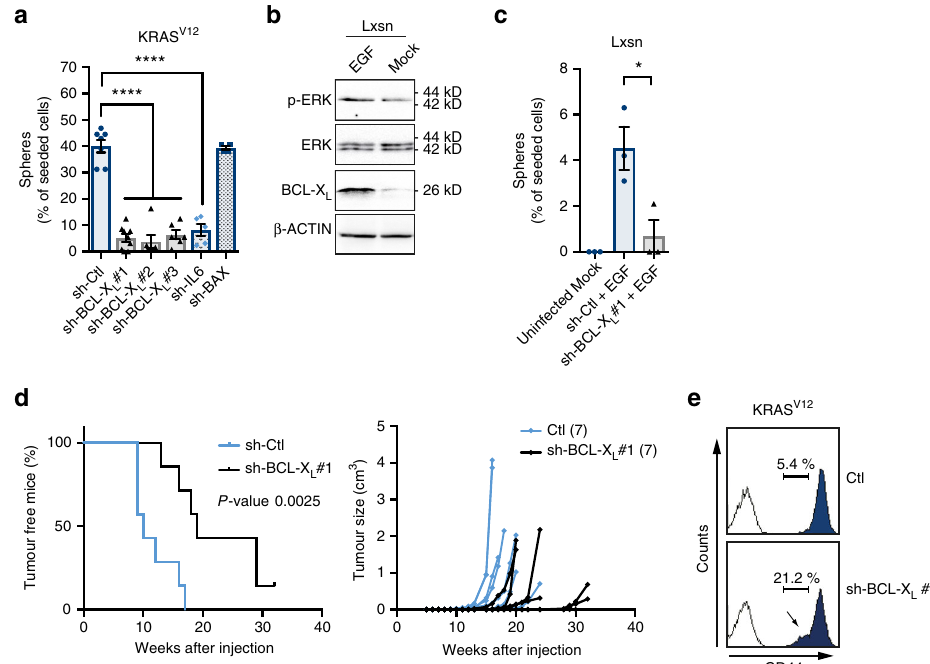
Fig. 2 BCL-X L maintains cancer initiating cell features induced by RAS activity in mammary cells. a , b Percentage of sphere forming cells in bulk population of a MCF10A KRAS V12 cells or c EGF-treated MCF10A Lxsn cells after 72 h infection with the indicated lentivector sh-RNAs. As comparison, the measured lack of sphere formation of Lxsn untreated with EGF is also illustrated. 128 cells per condition were seeded in serum-free media in ultra-low adhesion plates and the resulting spheres counted after two weeks incubation. Each dot represents the percentage of cell forming sphere for one biological replicate. Mean and SEM of at least 3 (3 to 6) independent experiments are represented (two-tailed unpaired t -test). b Western blot analysis of BCL-X L expression and ERK phosphorylation in MCF10A Lxsn cells after overnight starvation and treatment with 20 ng ml − 1 EGF for an additional 24 h d . Transplant experiment of MCF10A KRAS V12 cells infected with sh-BCL-X L or a control vector. 5 × 10 5 cells were subcutaneously injected in 7 Nu/Nu mice for each group and tumour growth was monitored (Log-rank (Mantel-Cox) test). e Flow cytometry analysis of CD44 expression on MCF10A KRAS V12 cells infected with sh-BCL-X L or a control vector 72 h prior staining. White histograms represent the IgG control staining; blue histograms represent the CD44 staining. Data from one representative experiment are